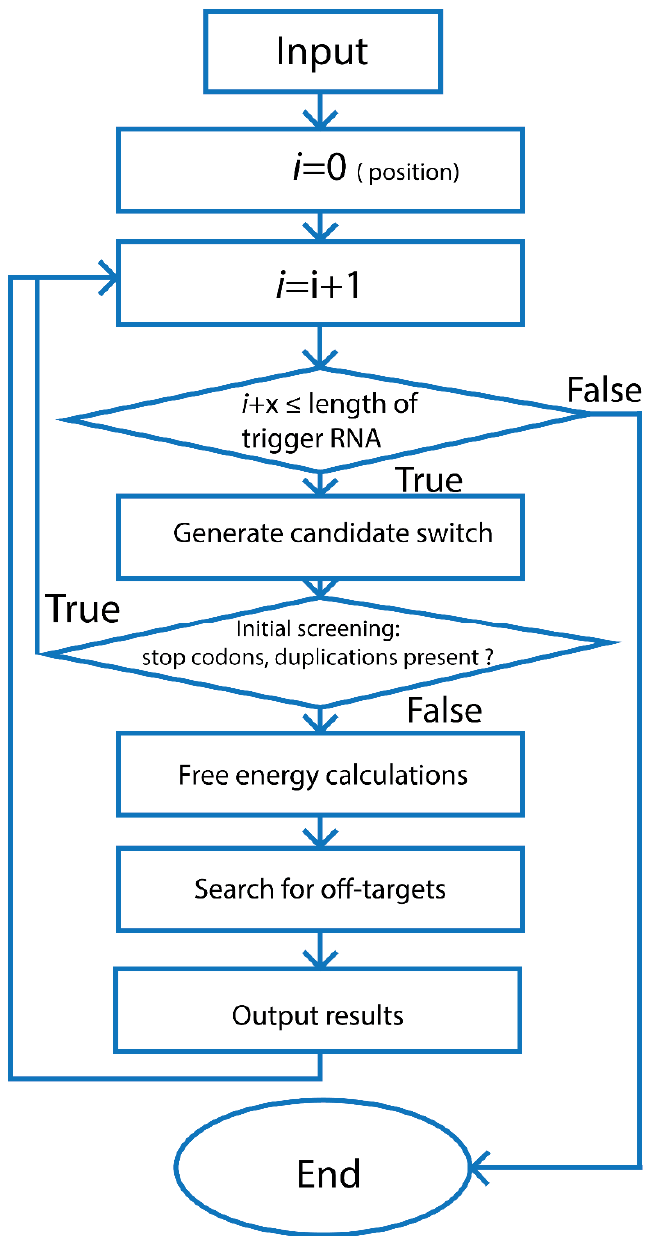
Figure 3. The workflow for in silico generation and screening of trigger RNA sequence pool. Generally, after checking the validity and format of the input target RNA template, the pool of candidate trigger RNA sequences (in which x is the user specified length for potential trigger RNAs) is generated by a sliding the position of a reading frame with length of x consecutive nucleotides throughout template target RNA by 1-nucleotide increment ( i = i+1; i +x ≤ length of trigger RNA). The candidate toehold switches generated from trigger RNA sequence pool are screened to ensure that there are no in-frame stop codons, as they would stop translation prematurely. After the candidate sequences pass initial tests, they are subjected to free energy calculation and off-target test. Additional constructs such as promoters or restriction sites can be added to the toehold switches. The candidate toehold switches are further trimmed down by calculating multiple ensemble defect levels based on deviation of sequences from their ideal secondary structures [77]. Adapted from To et al., A comprehensive web tool for toehold switch design; published by Bioinformatics , 2018 [77]. The Nucleic Acid Package (NUPACK) program, a software suitable for the design and analysis of nucleic acid systems, has been employed for the design of many toehold switch-based devices [71,77]. The program is used for free energy calculation of the predicted minimum free energy (MFE)